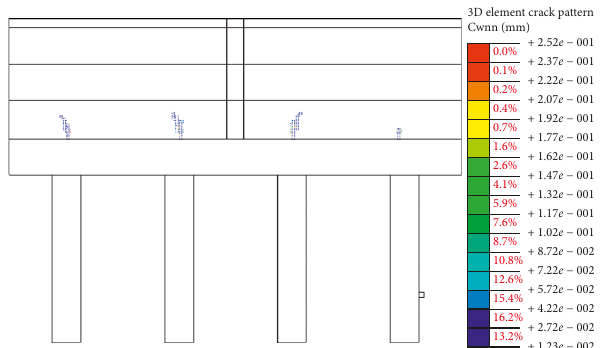
Figure 16: Crack width in the abutment after casting of the postcast strip